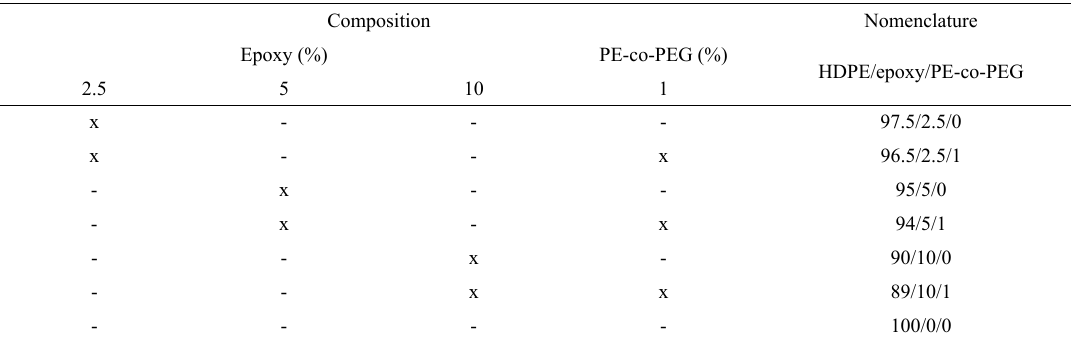
Table 2. Nomenclature and composition of the